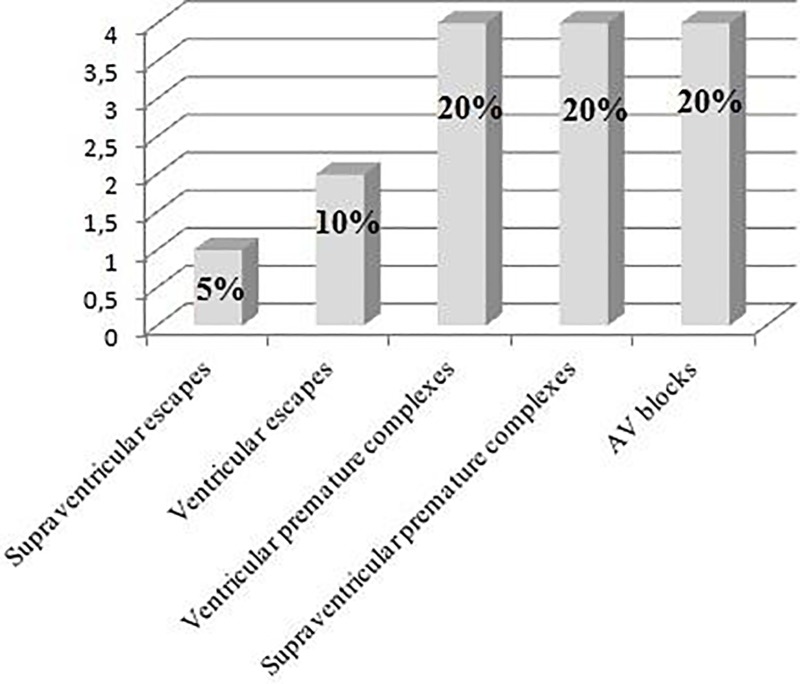
Chart showing the prevalence of arrhythmias during 24-hour recording for G1.